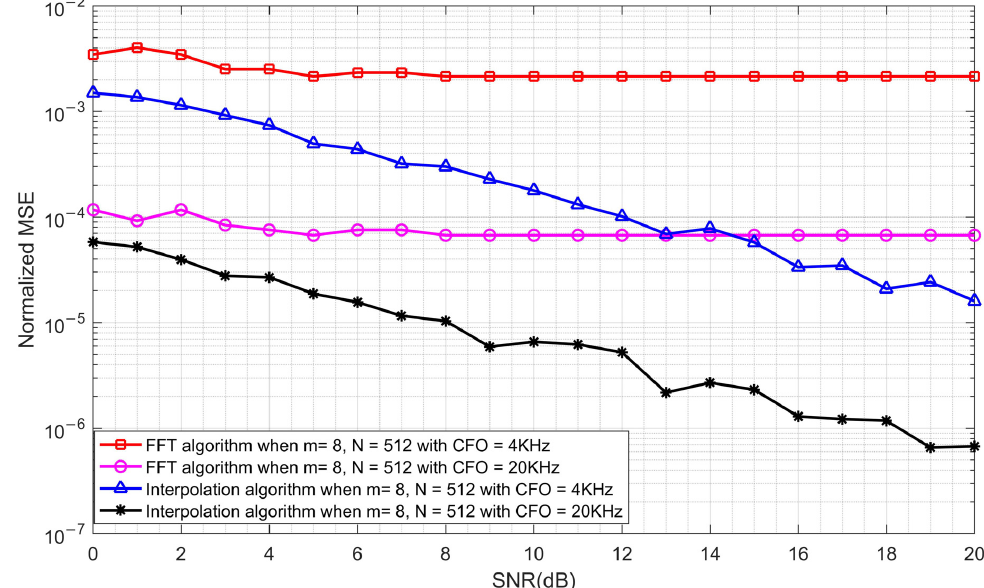
Figure 15. The normalized MSE comparison of the FFT algorithm and the quadratic interpolation algorithm when m = 8 and N = 512 with CFOs of 4 KHz and 20 KHz.